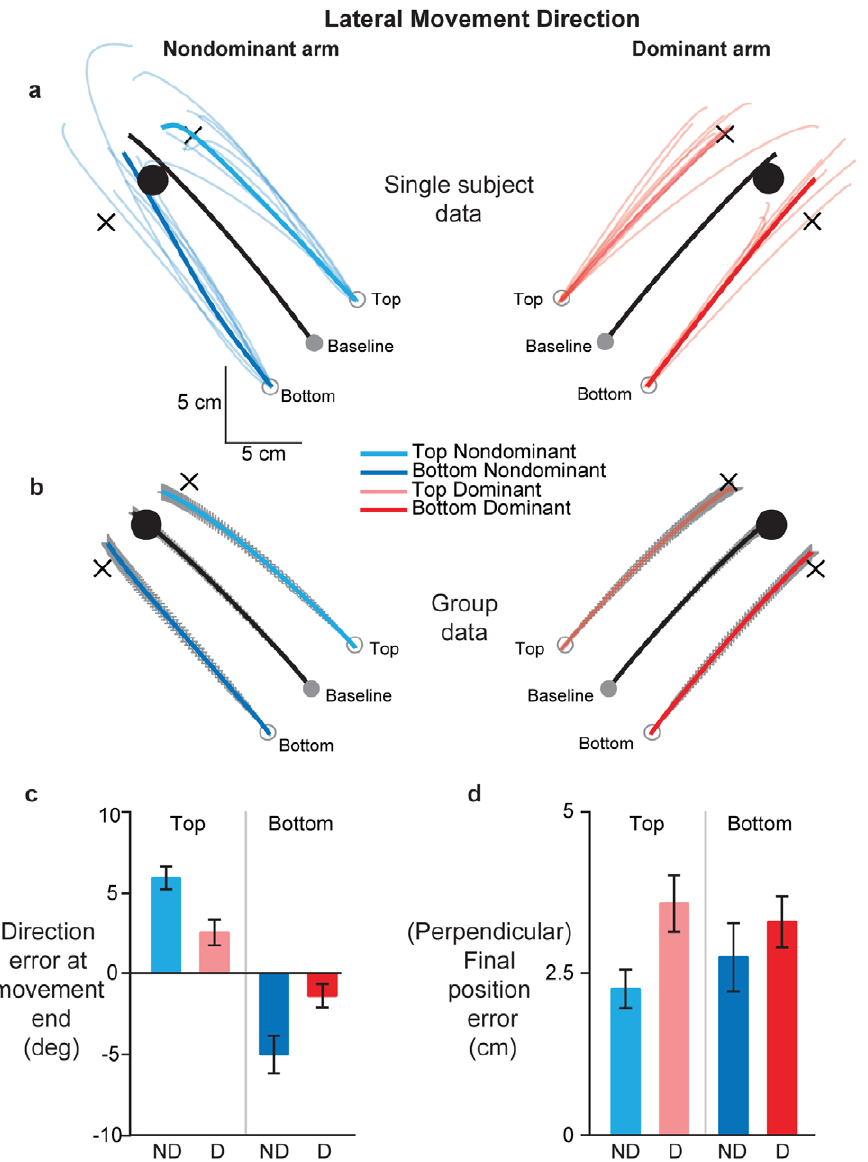
Figure 3. Effects of covertly shifting starting hand position orthogonally on dominant (red) and non-dominant (blue) arm movements in the lateral direction. (A) Hand trajectories for a single subject. Thin colored lines show individual probe trials, while thick colored lines show the mean of these individual trajectories. Light and dark colors show movements from the top and bottom start positions respectively. Thick black lines represent mean baseline movements. Black crosses represent virtual targets for the shifted start locations, parallel to baseline target direction and at the same distance as the baseline target. Note that subjects saw only the baseline start and target positions. (B) Mean hand trajectories across all subjects from the baseline and shifted start locations. Colors and line types represent the same information as in 2A . Gray lines represent SE. (C) Mean direction error at movement end and (D) Mean final position error relative to the baseline target across all subjects, separated by start location [top (light colors), bottom (dark colors)] and arm [dominant (red), non-dominant (blue)]. Error bars represent SE.